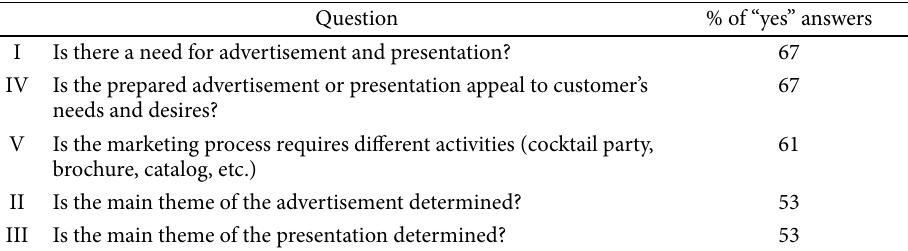
Table 4. Questionnaire results about the Efforts Spent in Promotion Process Question % of “yes” answers